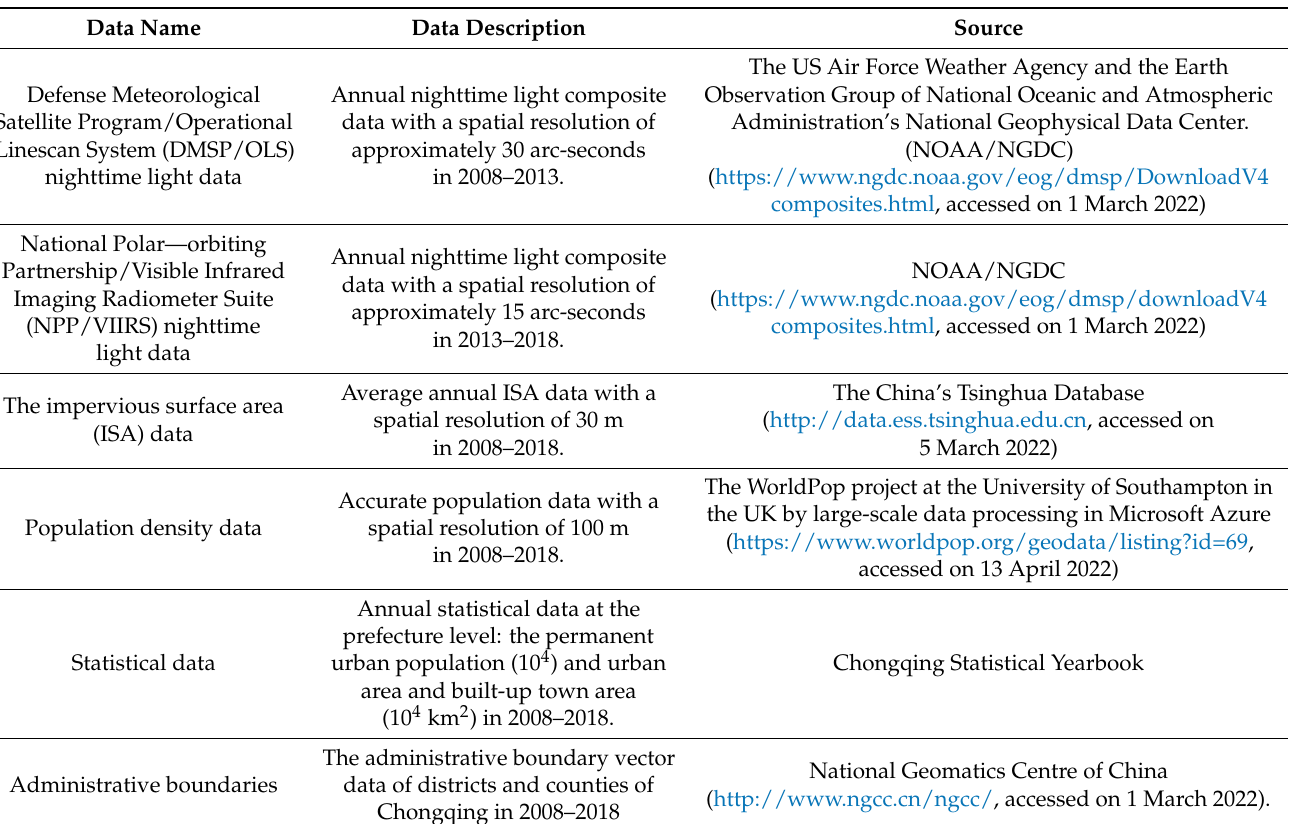
Table 1. Basic information of the data used in this